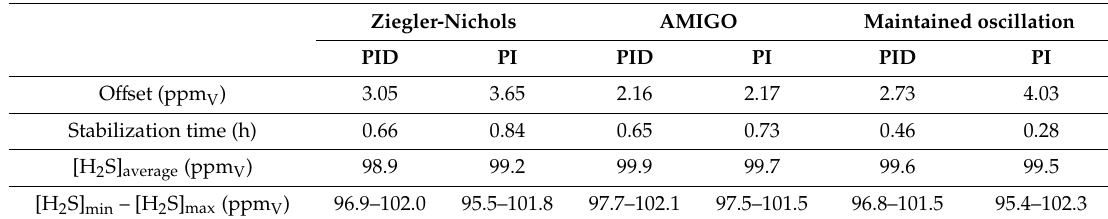
Table 5. Comparison of controller response.